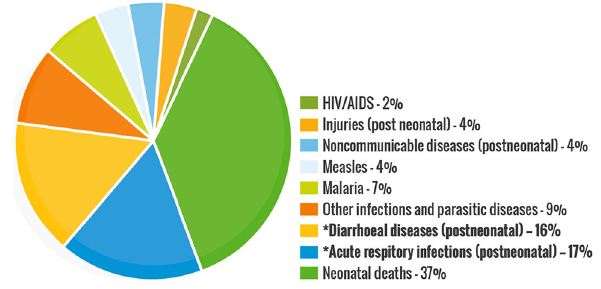
Fig. 1 Global statistics for disease burdens in